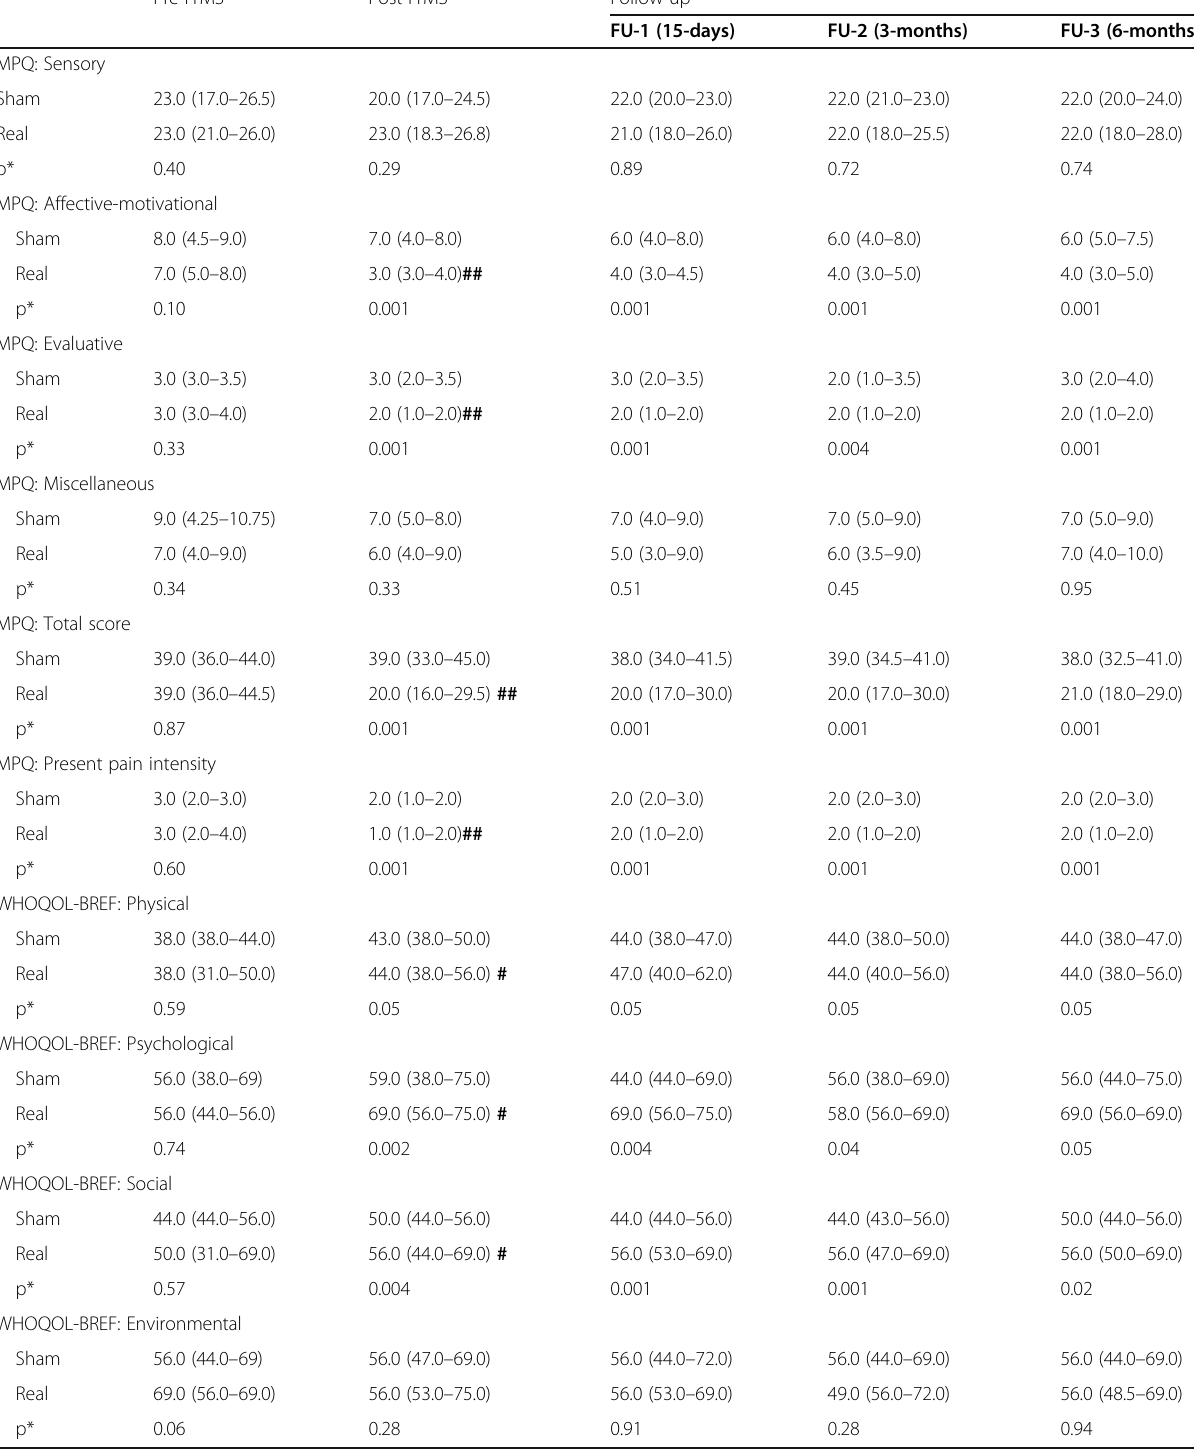
Table 2 Comparison of subjective pain measures in FMS Sham-rTMS and Real-rTMS group Pre-rTMS Post-rTMS Follow-up FU-1 (15-days) FU-2 (3-months) FU-3